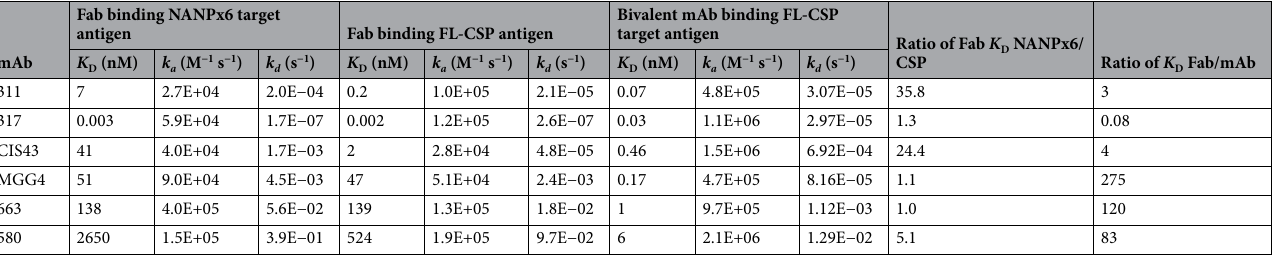
Table 1. Kinetic analysis of mAbs using bio-layer interferometry (BLI). Equilibrium dissociation constant ( K D ), association rate constant ( k a ), and dissociation rate constant ( k d ) of the antigen-binding fragment (Fab) and intact monoclonal antibodies (mAbs). Ratios represent K D values of Fab binding to NANPx6 / FL-CSP antigen; and ratio of K D values of Fab / intact mAbs binding to FL-CSP.